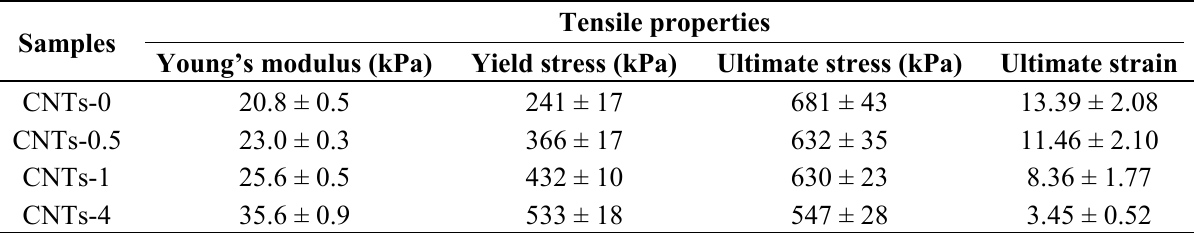
Table 2. The tensile properties of DN and nanocomposite DN